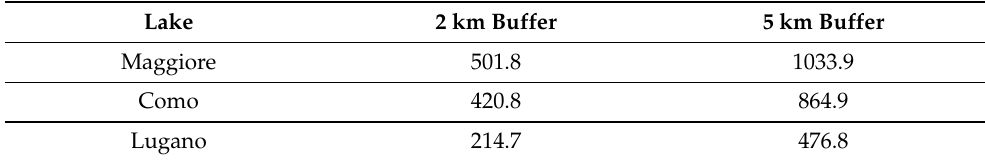
Table 1. Extensions [km 2 ] of the considered study